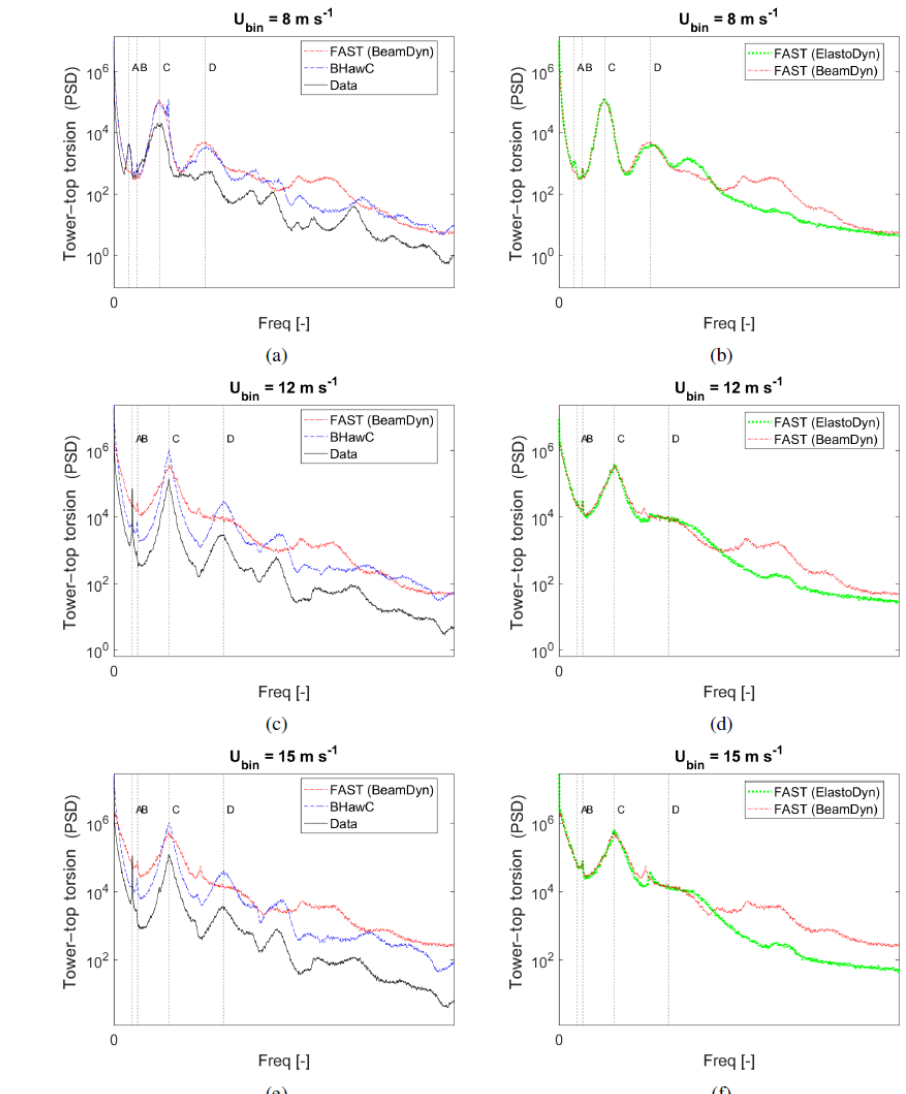
Figure 22. PSDs of the tower-top torsion moment. The three sets of graphs represent the ensemble-averaged PSDs from the inflow velocity bins at 8ms − 1 (top), 12ms − 1 (center), and 15ms − 1 (bottom).